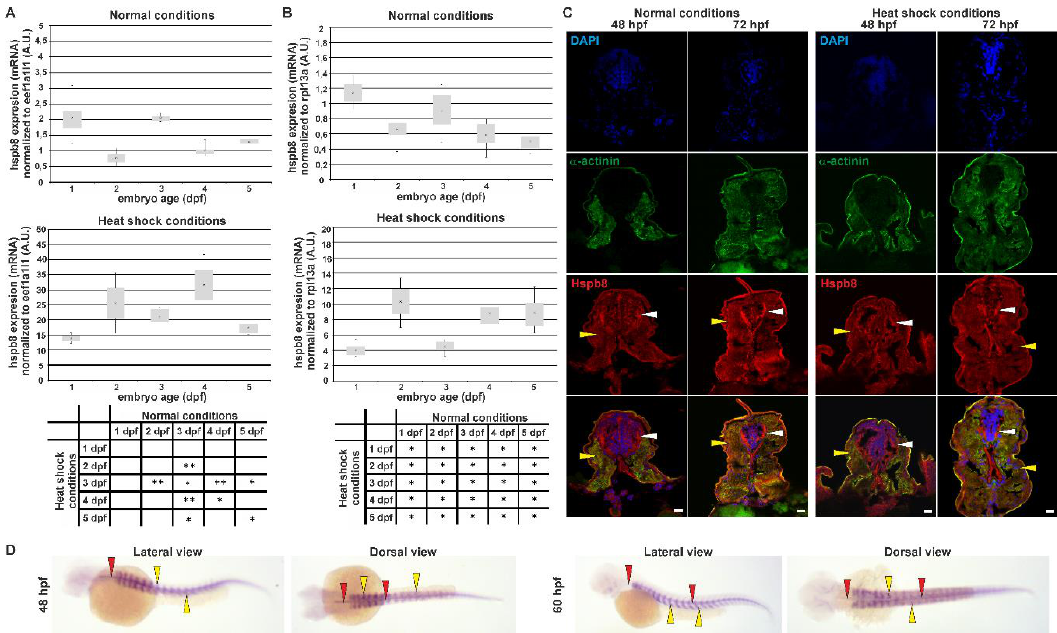
Figure 1. Tissue-specific expression and localization of Hspb8 during zebrafish development under normal and heat shock conditions. A and B. Real-time quantitative PCR (RT qPCR) of hspb8 mRNA expression level during zebrafish development (from 1 to 5 dpf) in normal (upper part A and B) and heat shock conditions (bottom part A and B). Expression of hspb8 mRNA was normalized to eef1a1l1 ( A ) and rpl13a ( B ). Error bars show the standard deviation. The tables below indicate the pairwise comparison between hspb8 expression level during zebrafish development (from 1 to 5 dpf) under normal and heat shock conditions. Statistically significant differences are indicated with *; * p < 0.05 and ** p < 0.001 (Student’s t-test). The experiment was performed 3 times, n = 25–30. A.U. = arbitrary unit. ( C ) Cross-sections of the mid-trunk region of 48 and 72 hpf zebrafish embryos under normal and heat shock conditions. The Hspb8 (red) localizes in muscle cells (yellow arrowheads) and the lateral spinal cord (white arrowheads). α-Actinin (green) is used to show muscles. Nuclei are stained blue. Cryosection (14 µ m thick). Images represent single cross-sections of the mid-trunk region (0.45 µ m thick). Scale bar: 10 µ m. Images were obtained with a confocal laser scanning microscope (Olympus FV1000). ( D ) hspb8 expression in 48 and 60 hpf zebrafish embryos under heat shock conditions, whole-mount in situ hybridization. The hspb8 mRNA localizes in muscles (yellow arrowheads) and the lateral spinal cord (red